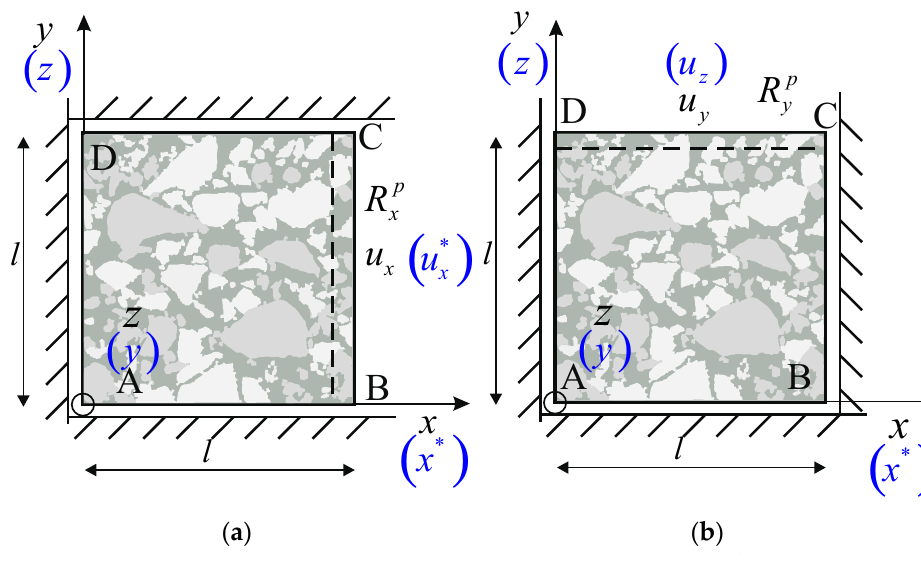
Figure 10. The schematic view of the boundary conditions assumed for the determination of the constrained effective moduli: ( a ) boundary BC, ( b ) boundary CD.